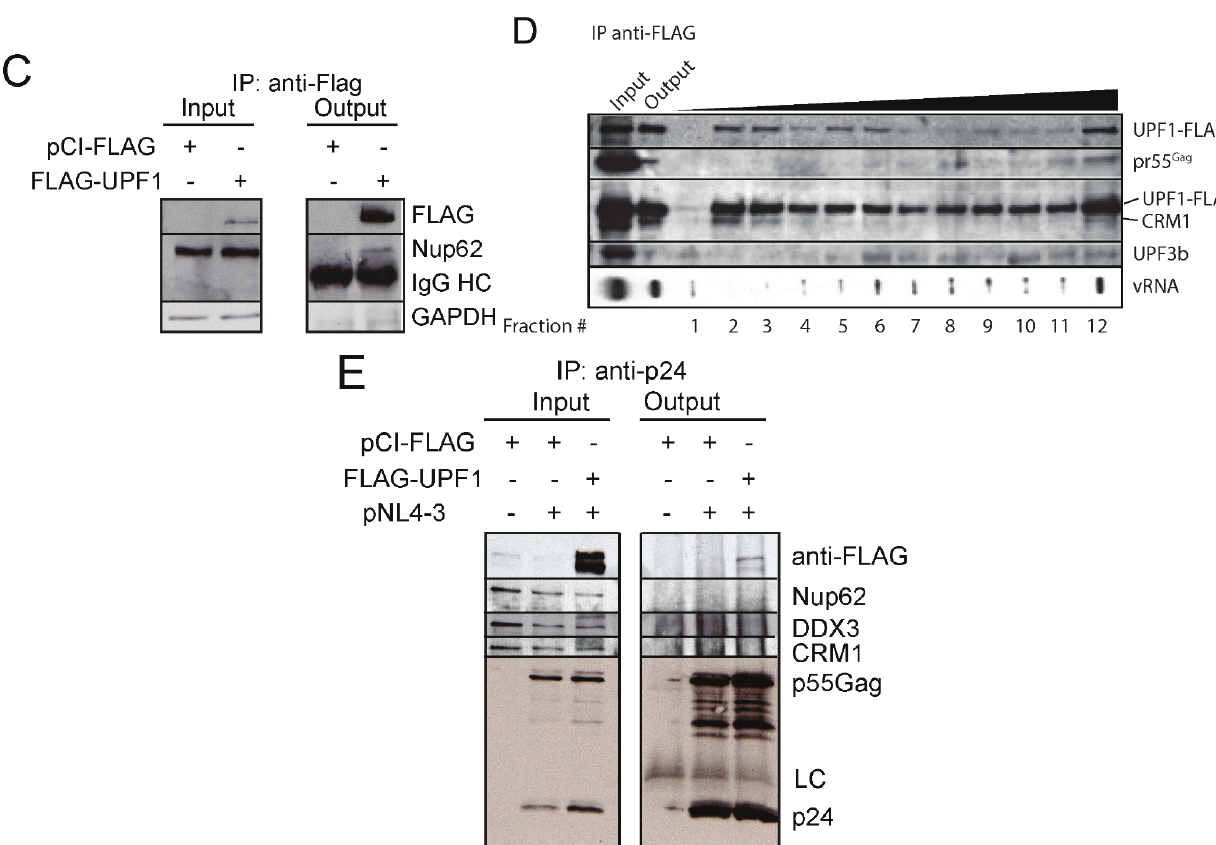
Figure 4. UPF1 is found in complex with Rev-CRM1-DDX3-Nup62. ( A ) HeLa cells were mock transfected with pCI-FLAG or transfected with FLAG-UPF1 alone or with either pMRev(cid:2) or Rev+ pNL4-3 DNAs. FLAG-UPF1 was immunoprecipitated as described in Materials and Methods. Input lysates and bound complexes were analyzed by western blotting for CRM1, FLAG-UPF1, Gag, DDX3 and GAPDH (loading and output control). HC: Heavy Chain IgG. Results shown are representative of three independent experiments; ( B ) HeLa cells were mock transfected with pCI-FLAG or FLAG-UPF1 or co-transfected with FLAG-UPF1 and Rev-R-YC. FLAG-UPF1 was immunoprecipitated and western blotting of input lysates and bound complexes for Rev, FLAG-UPF1, DDX3 and CRM1. HC: Heavy Chain IgG; ( C ) HeLa cells were mock transfected with pCI-FLAG or transfected with FLAG-UPF1. Cells were harvested and FLAG-UPF1 was immunoprecipitated as described in Materials and Methods. Western blotting analysis for FLAG-UPF1 and Nup62. IgG HC: IgG heavy Chain; ( D ) Glycerol gradient analyses of UPF1 complexes in HIV-1-expressing cells. HIV-1/FLAG-UPF1-expressing cells were immunoprecipitated with anti-FLAG serum. FLAG-UPF1 complexes were eluted and fractionated on a glycerol gradient. Fractions were collected and FLAG-UPF1, pr55 Gag , CRM1 and UPF3b were probed in each fraction by Western blotting. vRNA abundance is shown on the bottom panel, as determined by slot blot analyses; ( E ) HeLa cells were mock transfected with pCI-FLAG or co-transfected with HIV-1 and FLAG-UPF1. At 30 h post--transfection, Gag was immunoprecipitated using monoclonal anti-p24 antisera. Western for UPF1 (FLAG), Gag, CRM1, Nup62 and DDX3 were performed. Light Chain